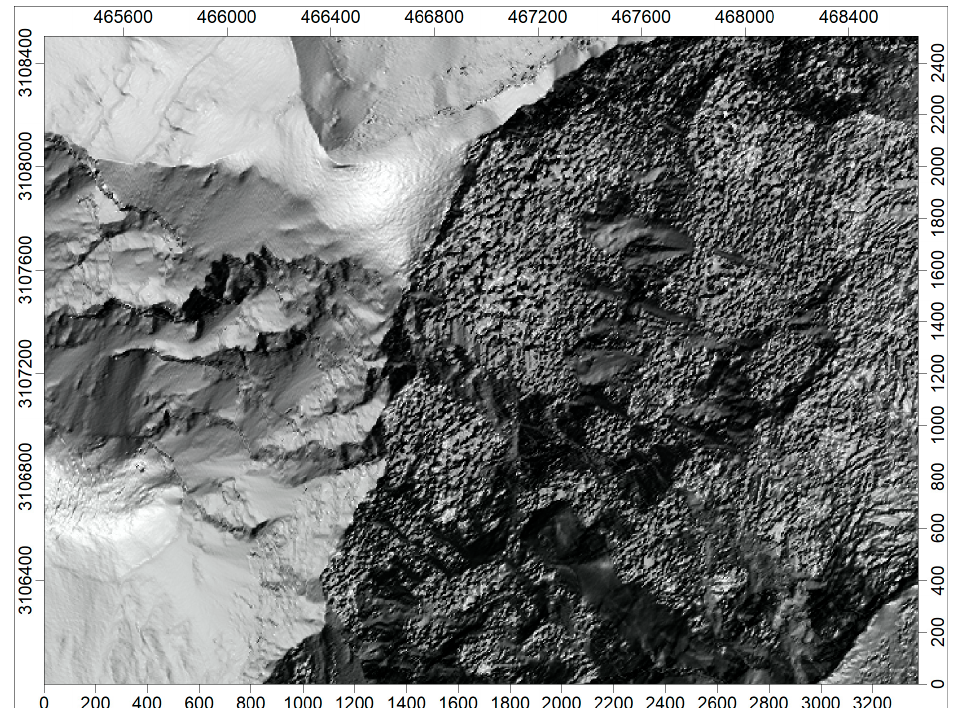
Figure 6. Hillshade of the spring 2016 DEM showing part of the highest area of the Ngozumpa glacier. A problematic area due to snow cover is clearly visible in the area east of the ridge.